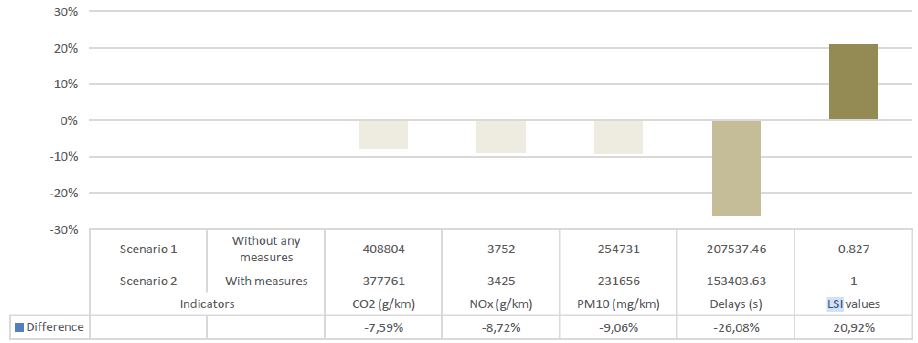
Figure 7. Percentage variation of environmental, delay, and LSI indicators. Reprinted from ref. [43].